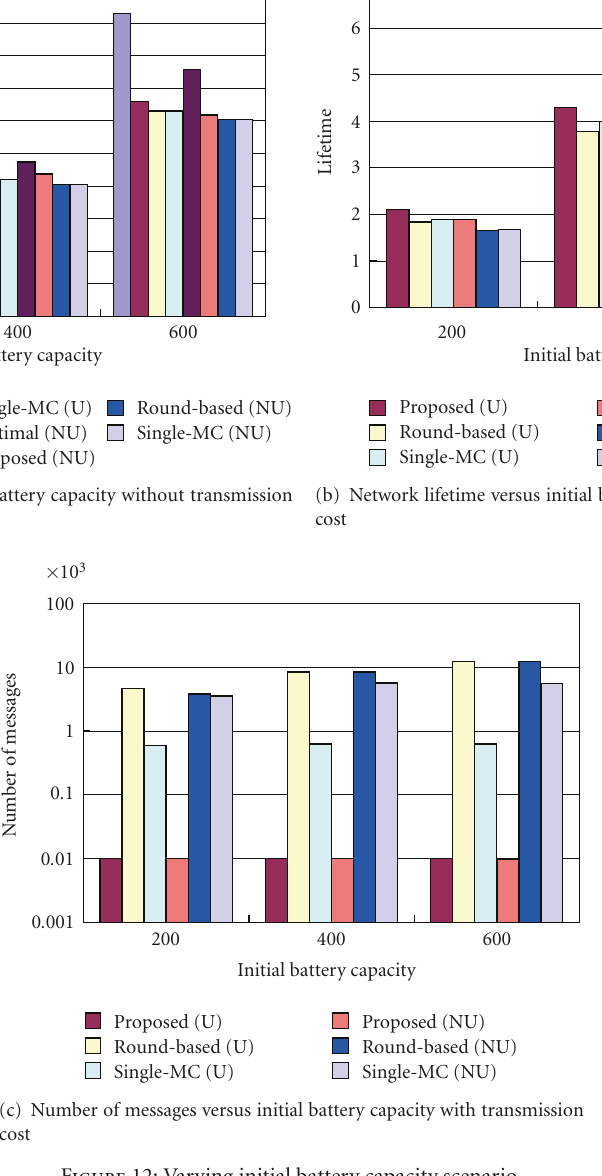
Figure 12: Varying initial battery capacity